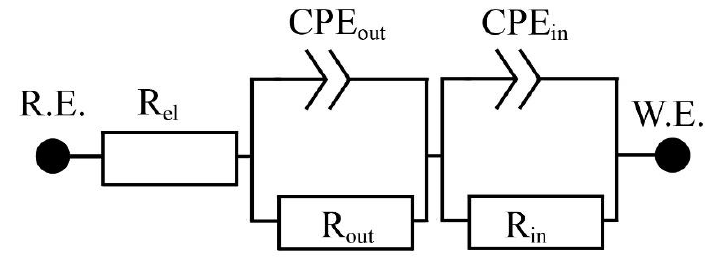
Figure 7. Equivalent circuit used to evaluate EIS spectra.